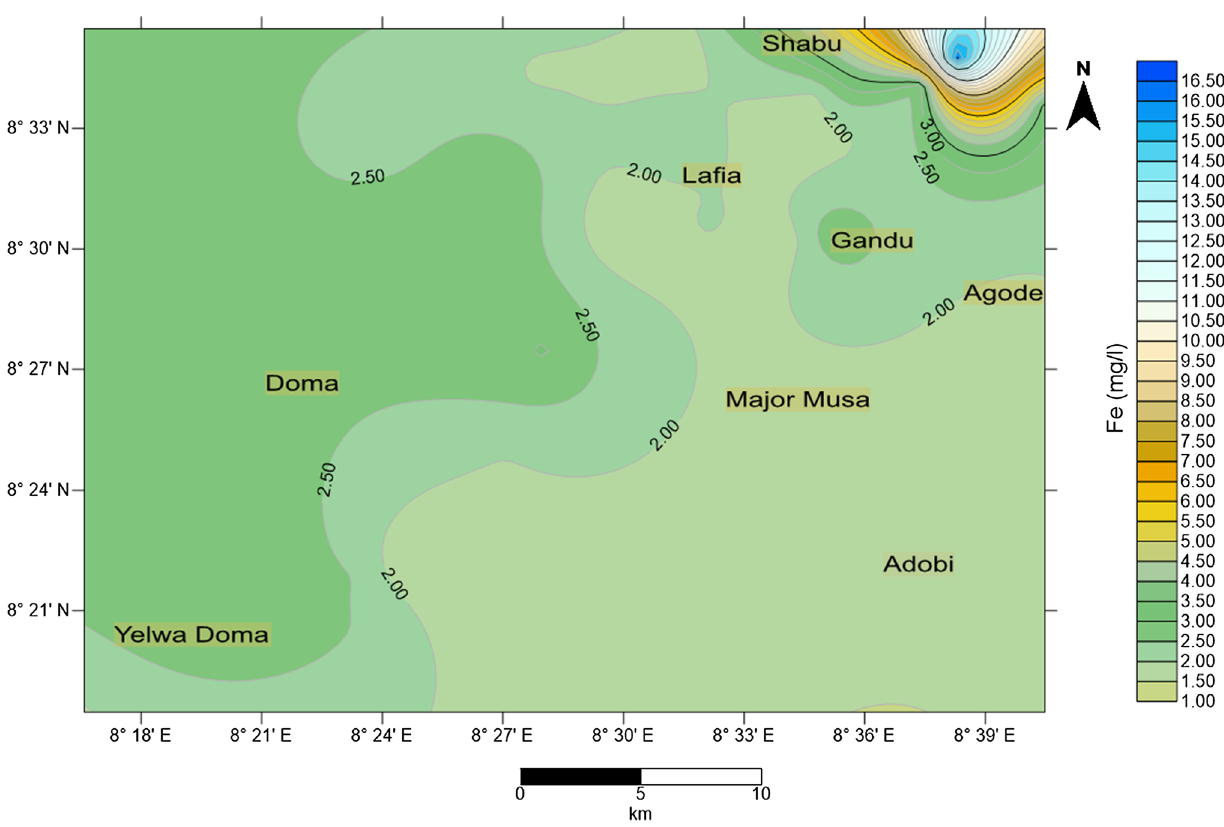
Fig. 8 Map showing the distribution of Fe 2+